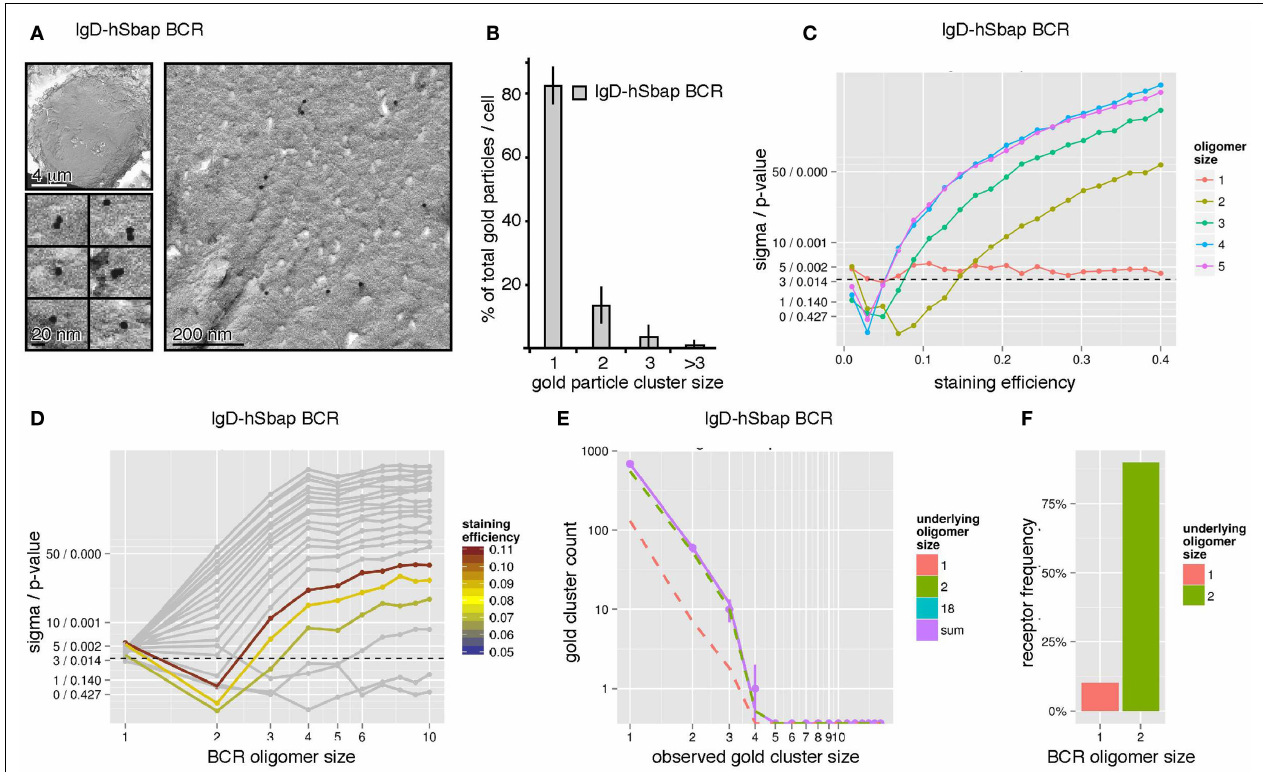
explanation for the observed gold cluster distribution. (D) Simulations were performed as in (C) . Assuming a staining efficiency of approximately 8% (color coding), sigma/ p -values ( y -axis) are plotted for the different BCR oligomer sizes ( x -axis). (E) Gold cluster counts (dots with error bars) compared to prediction of best fitting model (continuous line).The number of counts originating from monomers and dimers are shown as dashed lines, indicating that the observed distribution is dominated by BCR dimers. (F) A model with BCR monomers and dimers was fitted to the data, predicting that 90% of all receptors are part of dimers, 10% are